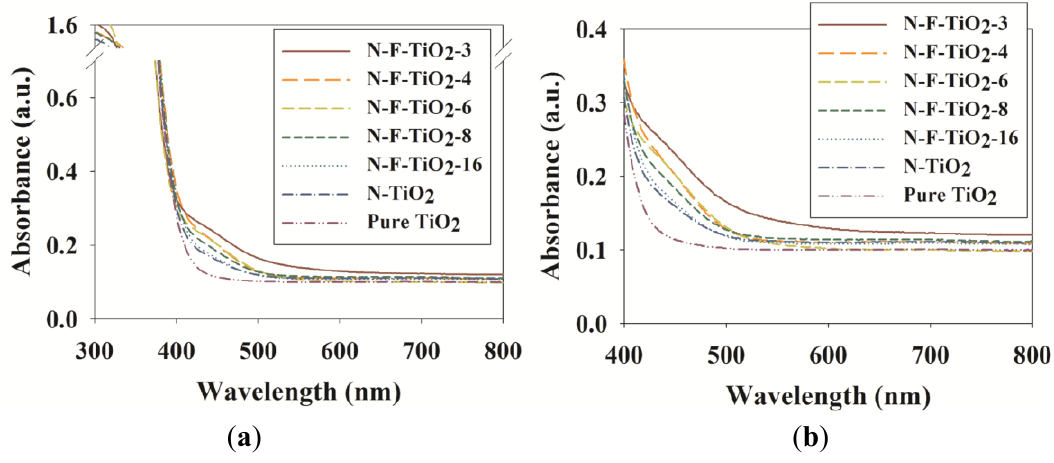
Figure 3. ( a ) UV-Vis spectra of N–F–TiO 2 with different N:F ratios (N–F–TiO 2